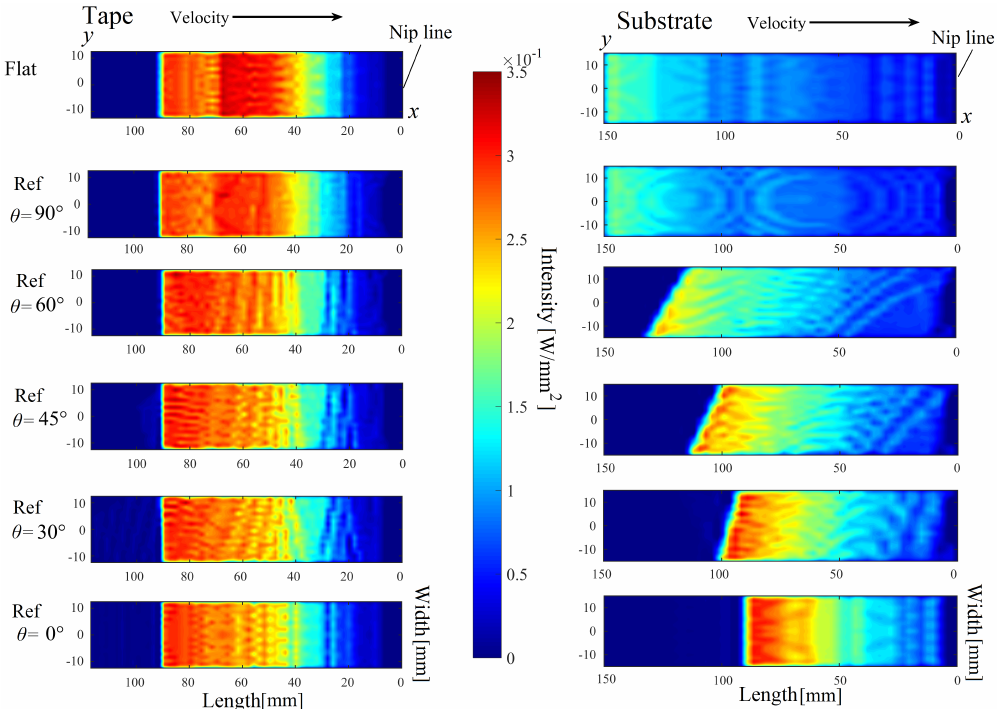
Figure 10. Absorbed power intensity distribution on the tape and the substrate for the cases Flat and Ref ( W T = 25 mm and W S = 30 mm) using different θ . (For interpretation of the references to color in this figure legend, the reader is referred to the web version of this article).